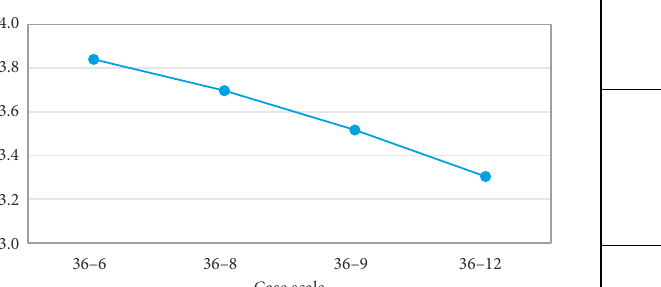
Figure 6. The trend of gap with the increasing subblocks